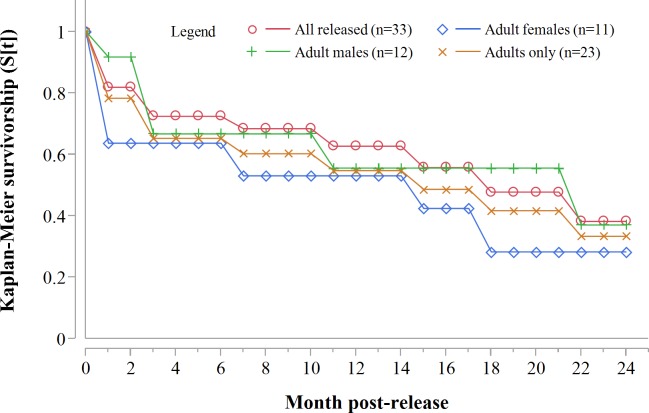
Progressive Kaplan-Meier survivorship estimates for translocated cheetahs in Namibia.Data standardised to month post-release.